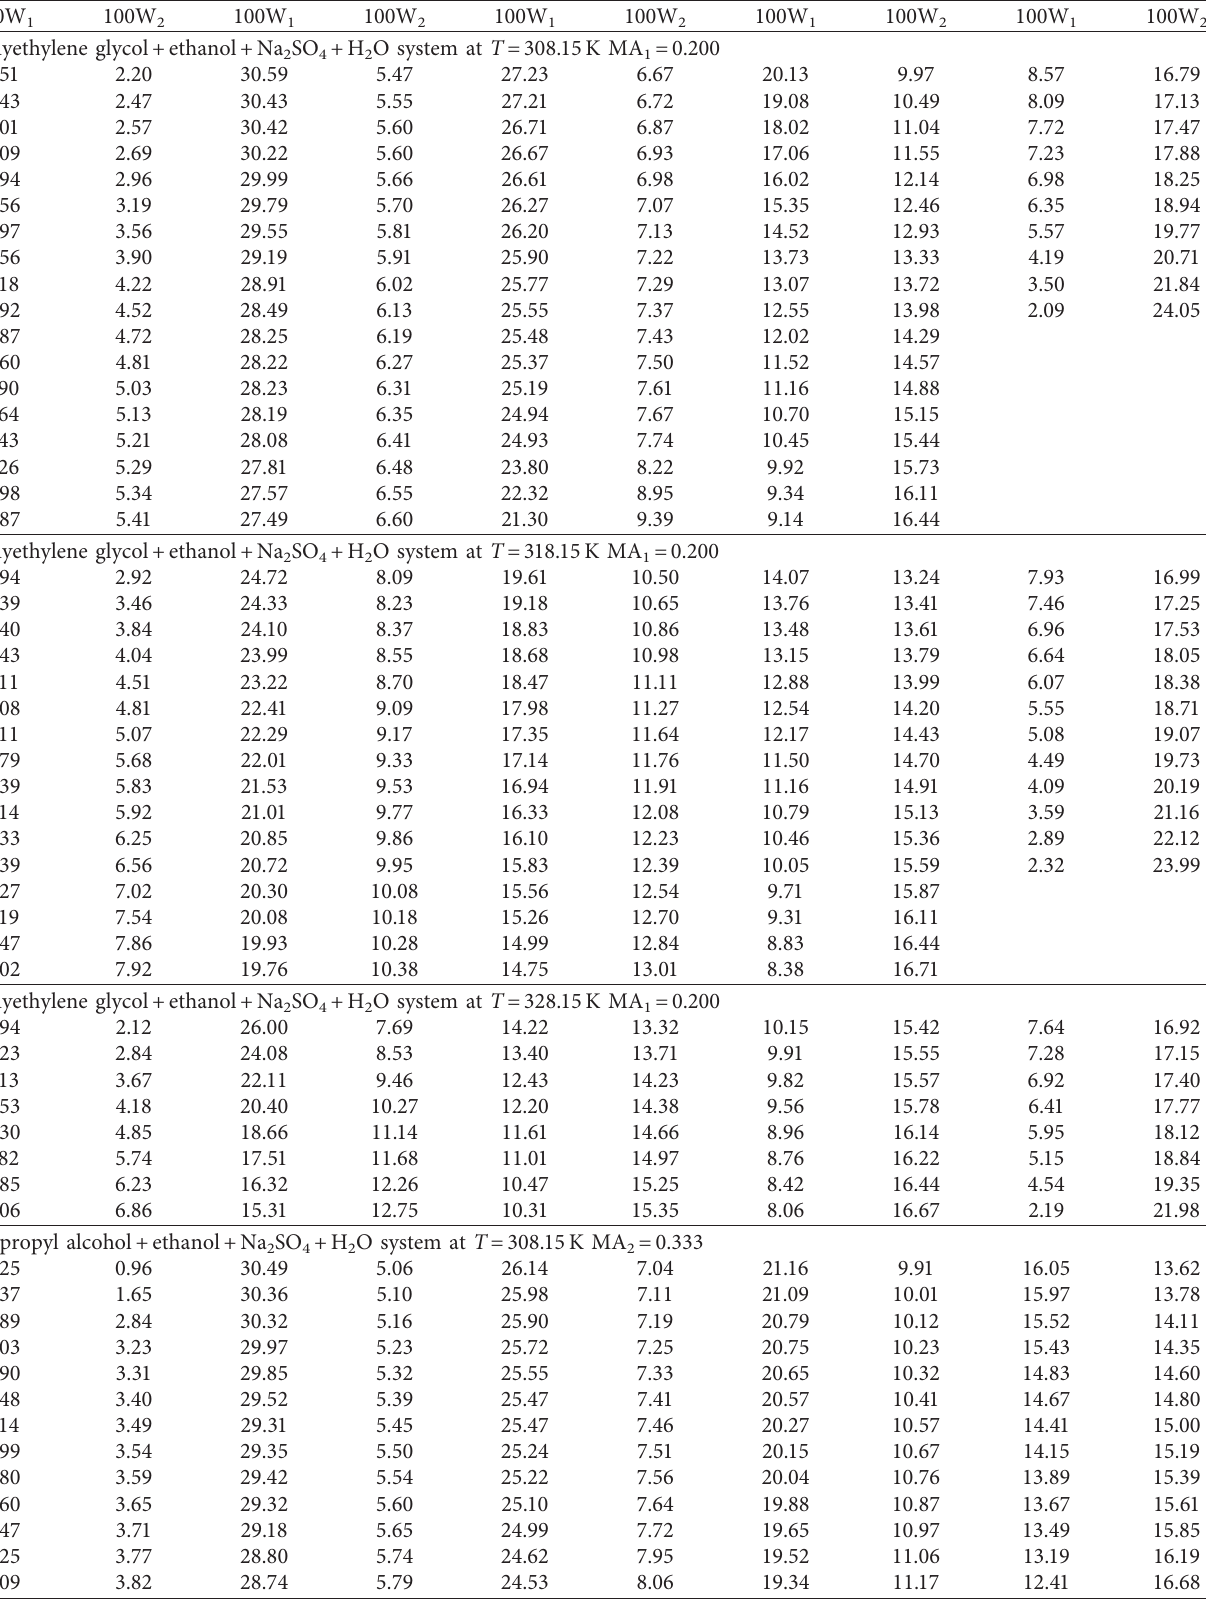
Table 2: Binodal data for the mixture of polyethylene glycol/isopropyl alcohol +ethanol +salt (Na temperatures a